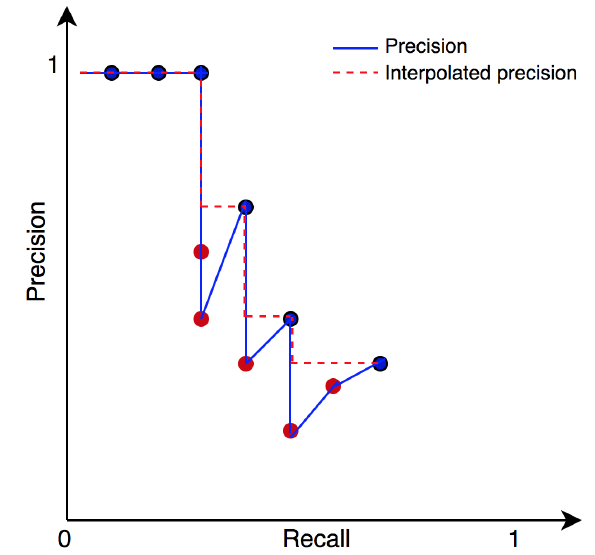
Figure 5. The precision/recall